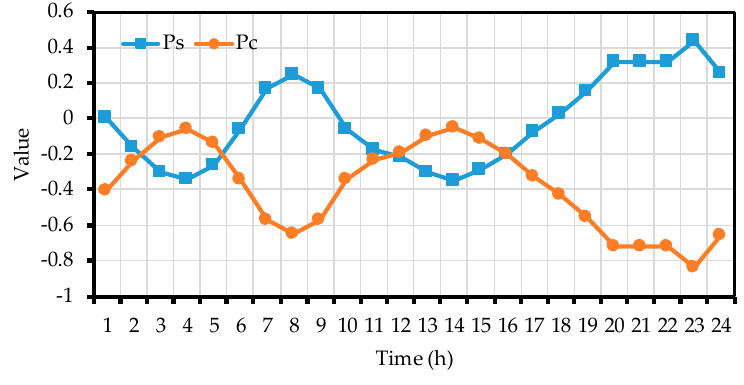
Figure 14. Values of Ps and Pc at each hour.